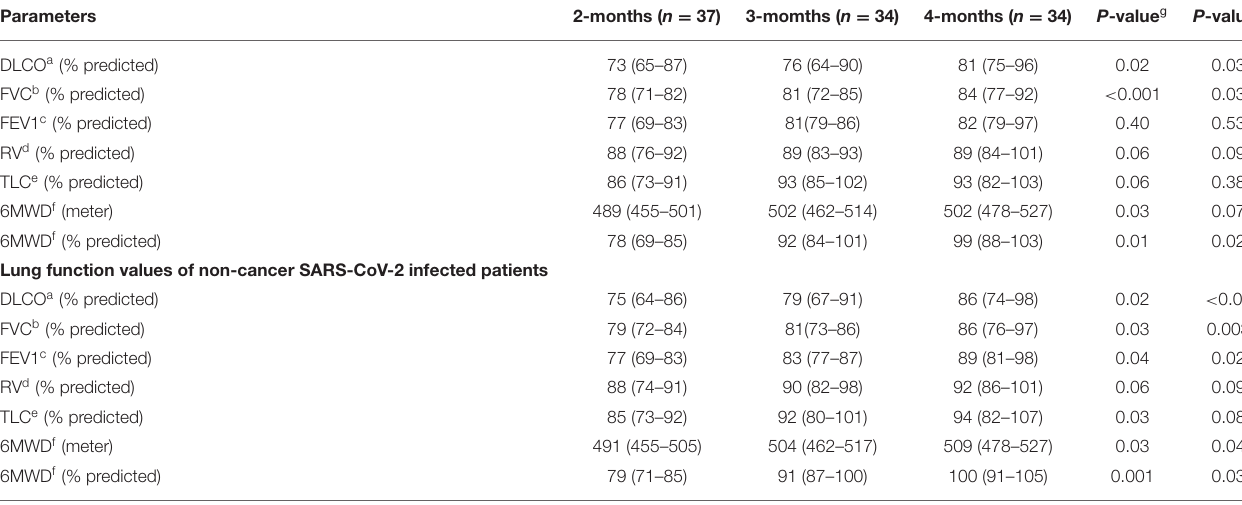
TABLE 4 | Lung function values of patients who received chemotherapy 2–6 months before severe acute respiratory syndrome coronavirus 2 (SARS-CoV-2) infection. Parameters